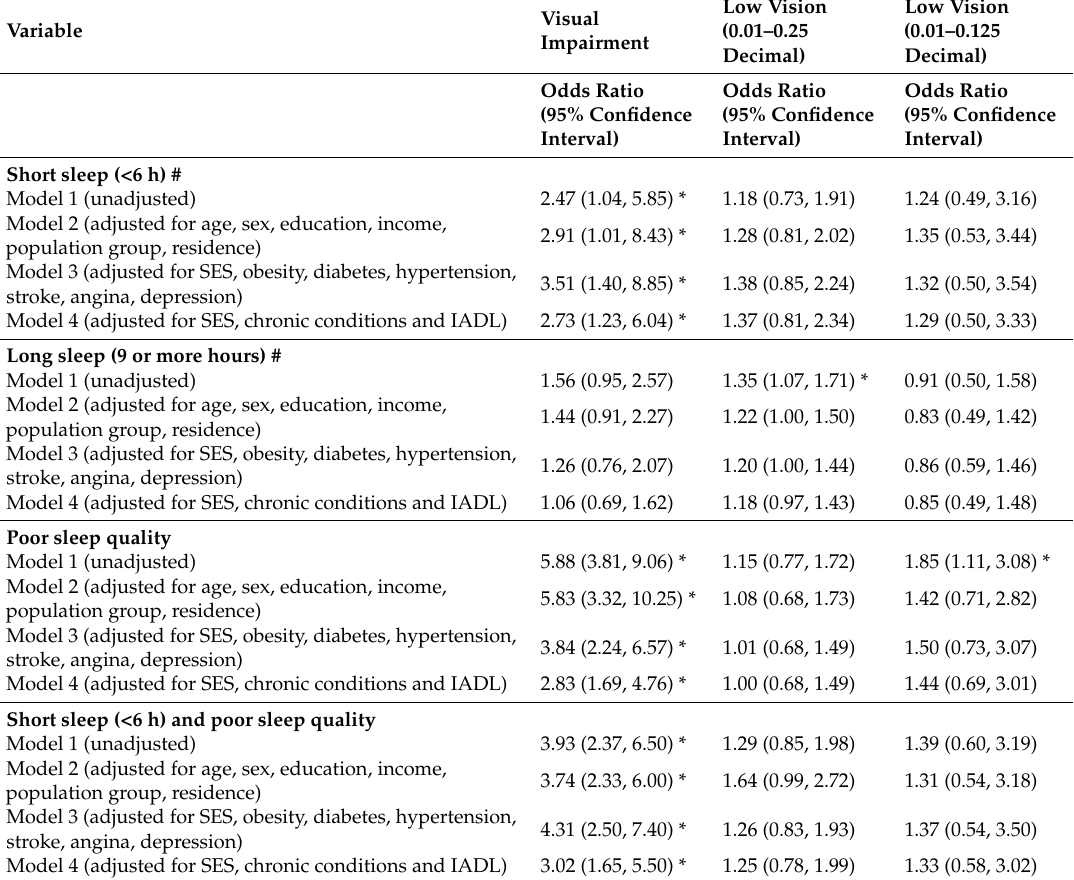
Table 2. Associations between visual impairment, low vision and sleep duration and poor sleep quality